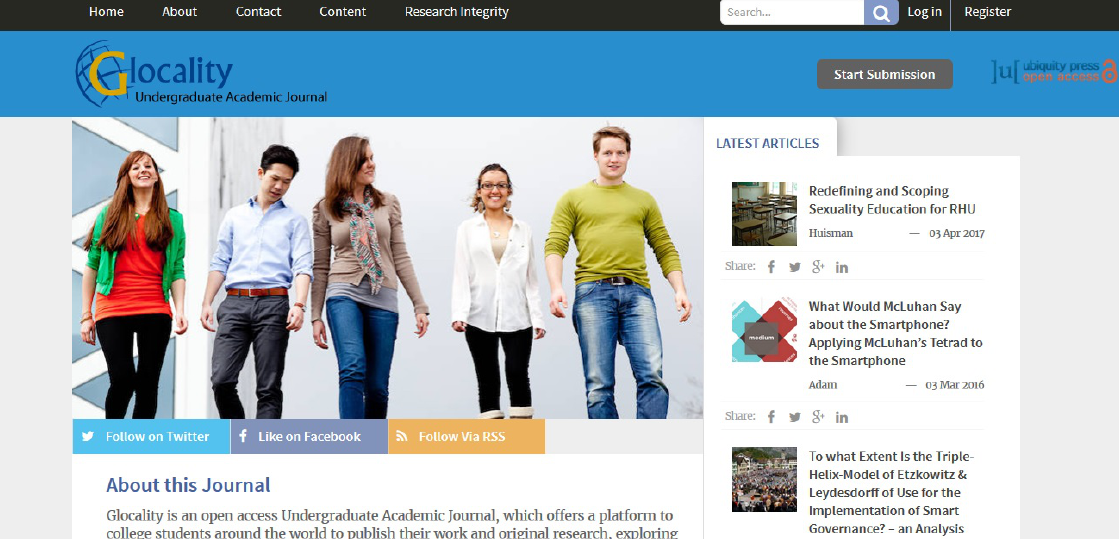
Figure 1. Screenshot of Glocality